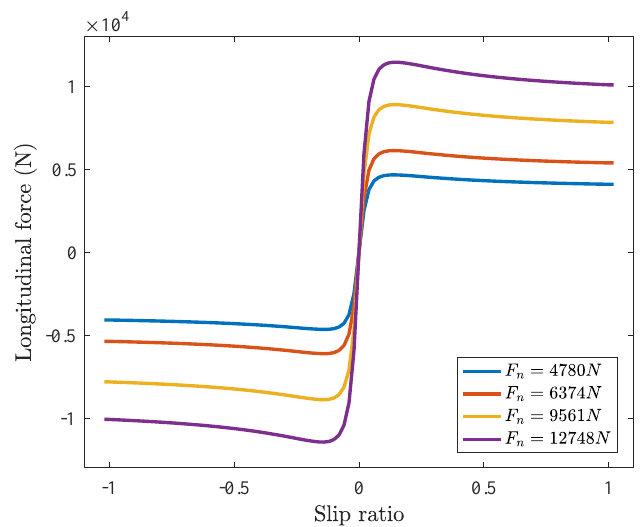
Figure 4. The longitudinal forces with different vertical forces F n .